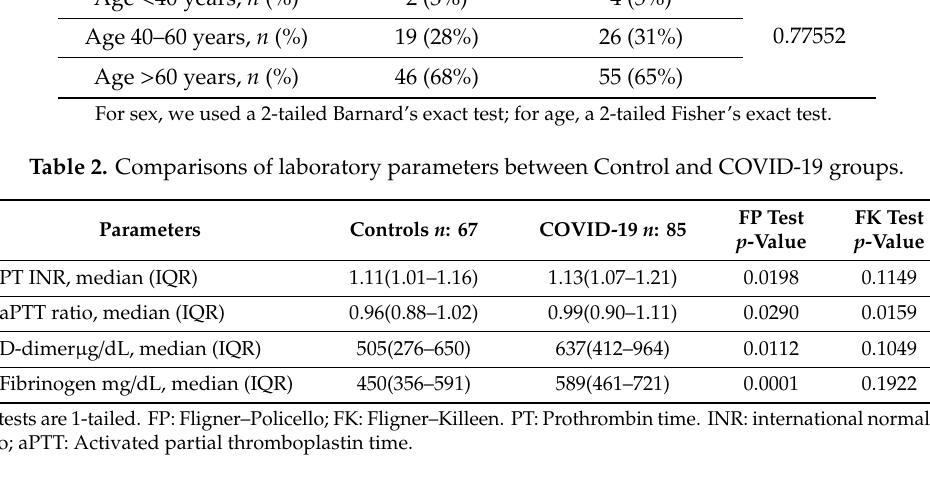
Table 3. Demographic characteristics of the study population according to the presence or not of acute respiratory distress syndrome (ARDS).